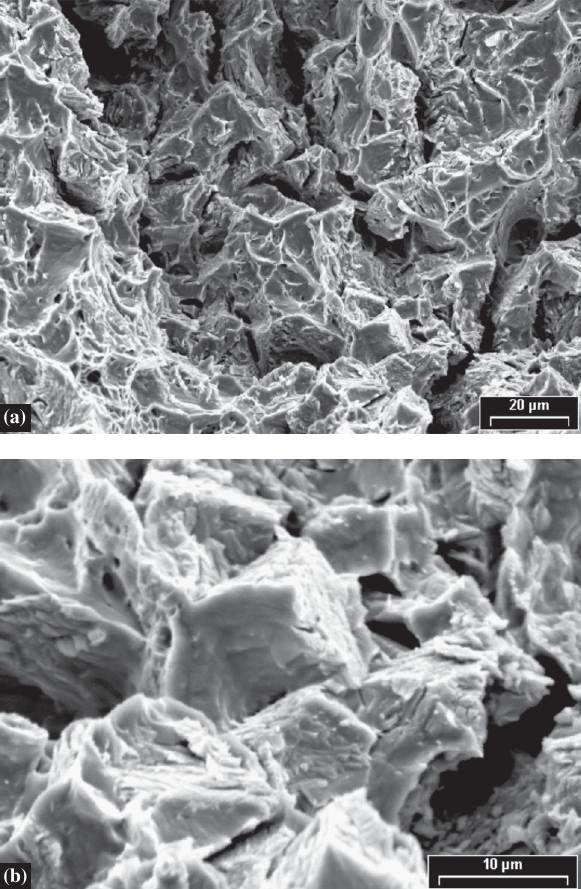
Figure 6. Fracture surface observation by SEM, showing a) mixed mode of fracture, b) a magnified zone of a.